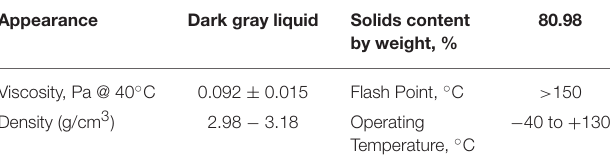
TABLE 1 | Material properties of